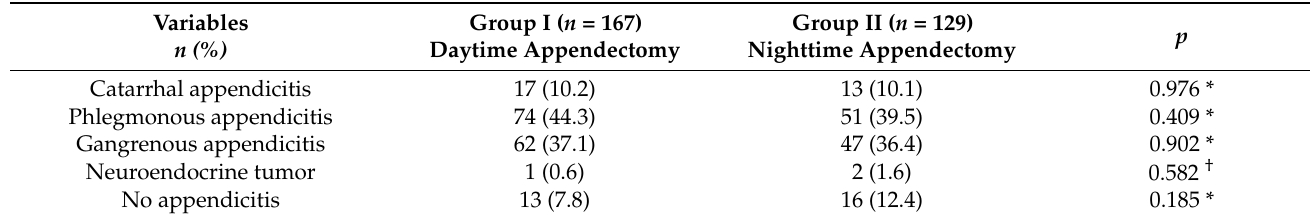
Table 2. Pathohistological analysis of removed specimens.